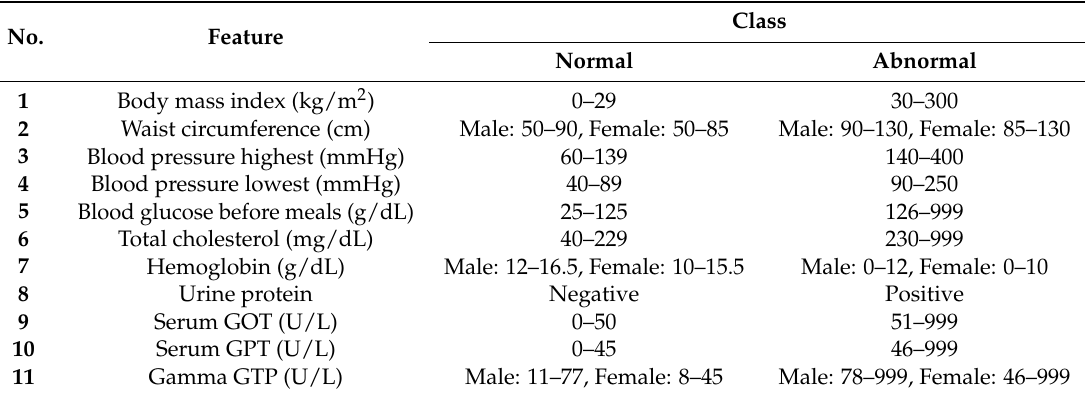
Table 4. Normal/abnormal criteria of GHE-DB